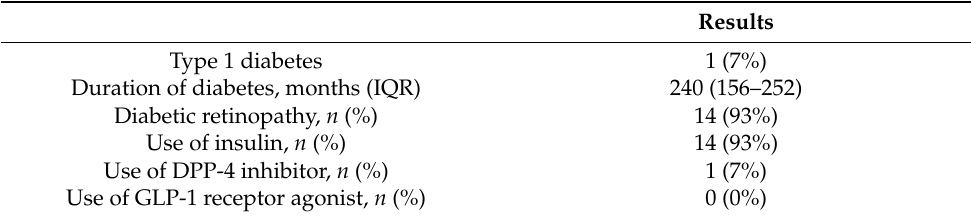
Table 2. Risk factors for diabetic autonomic neuropathy in the DM group. Results Type 1 diabetes 1 (7%) Duration of diabetes, months (IQR) 240 (156–252) Diabetic retinopathy, n (%) 14 (93%)